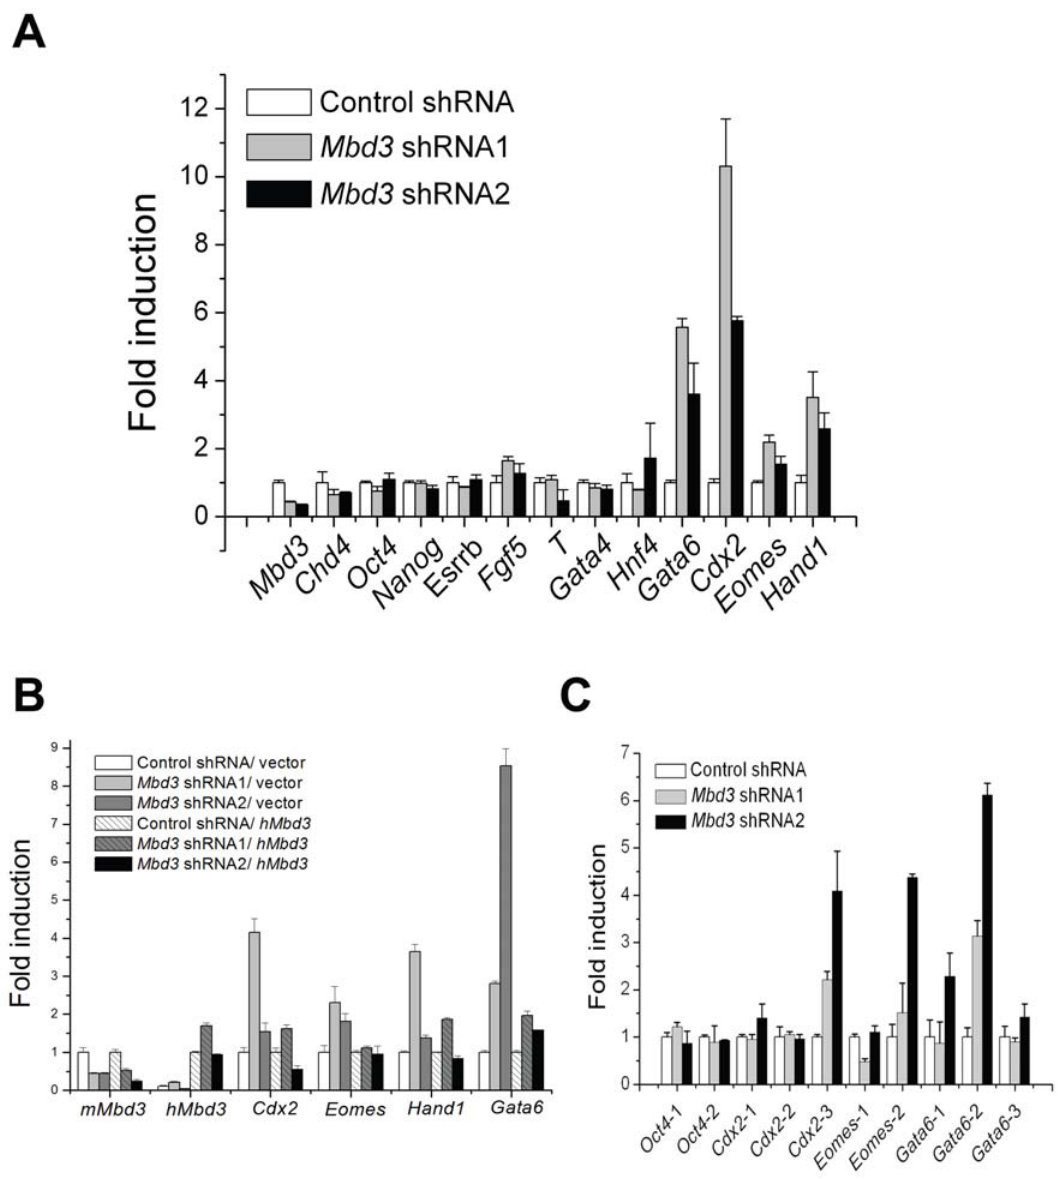
Figure 2. Suppression of Mbd3 results in the upregulated gene expressions of trophectoderm lineage markers in CGR8 cells. Equal amounts of DNase-treated total RNA were subjected to quantitative RT-PCR analysis (A, B). A) Cells were transfected with shRNA plasmids and selected for six days with puromycin. B) Cells were co-transfected with a shRNA plasmid and human Mbd3 or control plasmid and selected with both puromycin and G418 for five days. The target sequences in Mbd3 shRNA1 and 2 do not exist in human Mbd3 sequence. C) Chromatin immunoprecipitation (ChIP) analysis using acetylated histone 3 antibody. CGR8 cells were transfected with shRNA plasmids and selected for five days with puromycin. Various pairs of PCR primer were designed to scan respective promoters. Gene expressions were normalized to internal control b - actin and presented as the fold induction relative to control samples. Error bars in panel A, B and C represent standard deviation from three technical